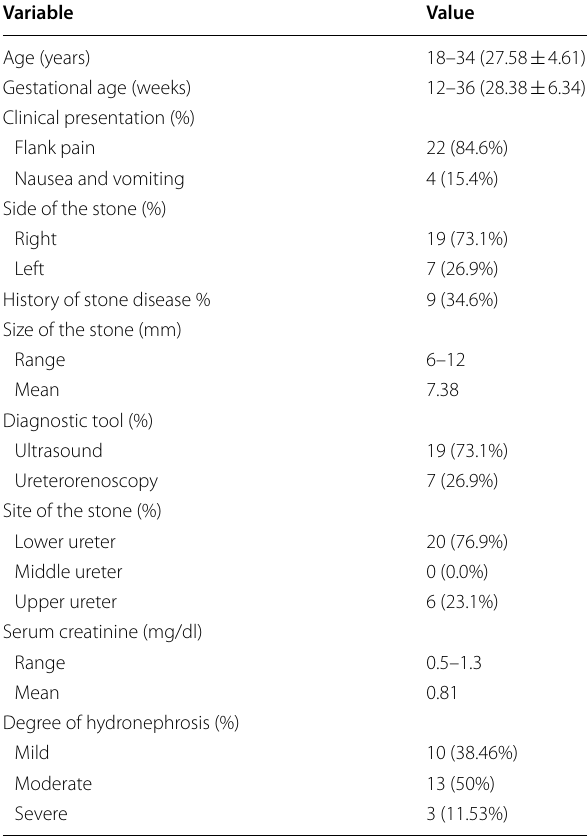
Table 1 The patient characteristics and descriptive